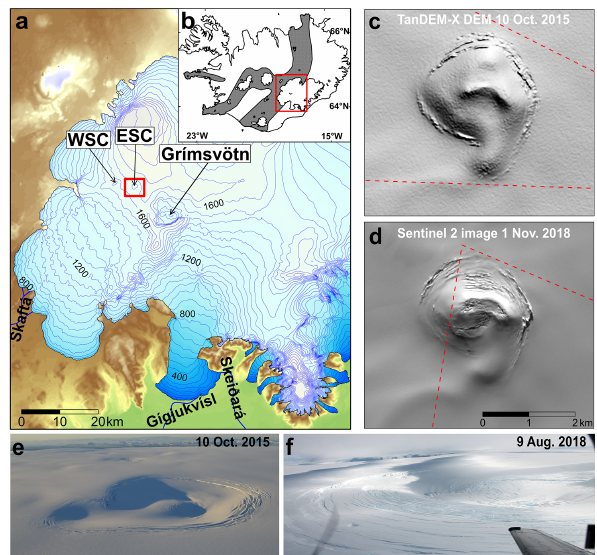
Figure 1. (a) The western part of Vatnajökull ice cap (red box in panel b ) situated within the volcanic zones of Iceland (grey areas in panel b ) and the locations of the Grímsvötn subglacial lake and the lakes beneath the Skaftá cauldrons (WSC and ESC). Jökulhlaups from the Skaftá cauldrons drain to the river Skaftá. Jökulhlaups from Grímsvötn drained until 2009 into the river Skeiðará (approxi- mate position around the year 2000) and since then into the river Gígjukvísl. (c) TanDEM-X DEM of the eastern Skaftá cauldron (ESC) obtained a week after the jökulhlaup in 2015 represented as shaded relief (DEM location shown with red square in panel a ). (d) Sentinel-2 optical image of the same area as in panel (c) showing the ESC almost ∼ 3 months after the jökulhlaup in 2018. (e–f) Pho- tographs taken about 1 week after the 2015 ( e by Benedikt Ófeigs- son) and 2018 ( f by Magnús T. Guðmundsson) jökulhlaups. The viewing angles are indicated with dashed red lines in panels (c) and (d) ,